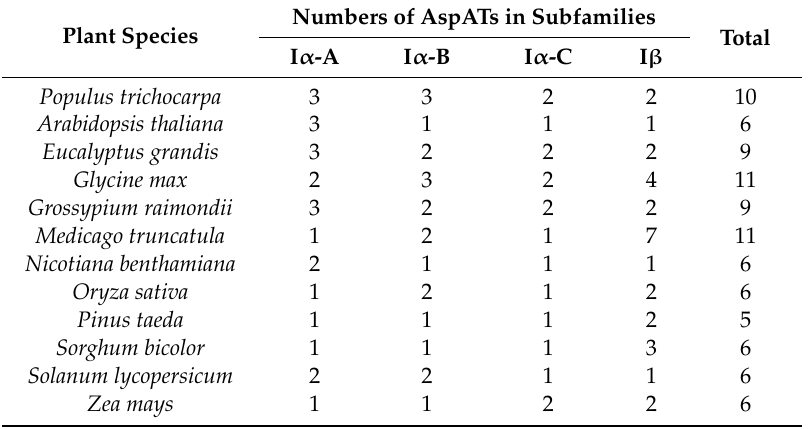
Table 1. Numbers of AspAT encoding genes identified in a variety of plant